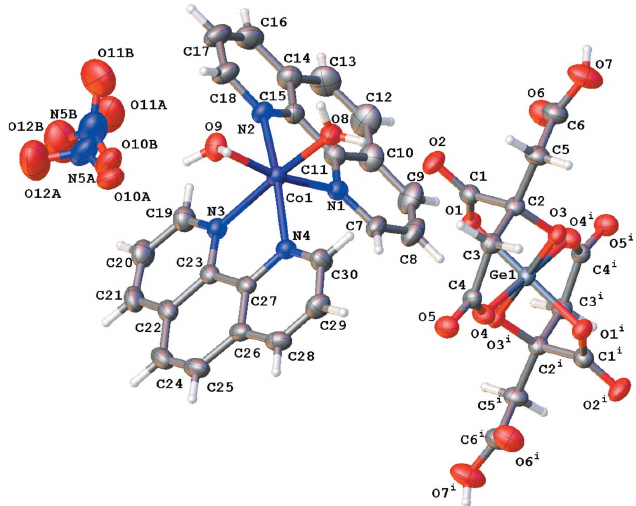
Figure 1 The molecular structure of [Co(H 2 O) 2 (phen) 2 ] 2 [Ge(HCit) 2 (NO 3 ) 2 ] [symmetry code: (i)1 (cid:2) x , 2 (cid:2) y , 1 (cid:2) z